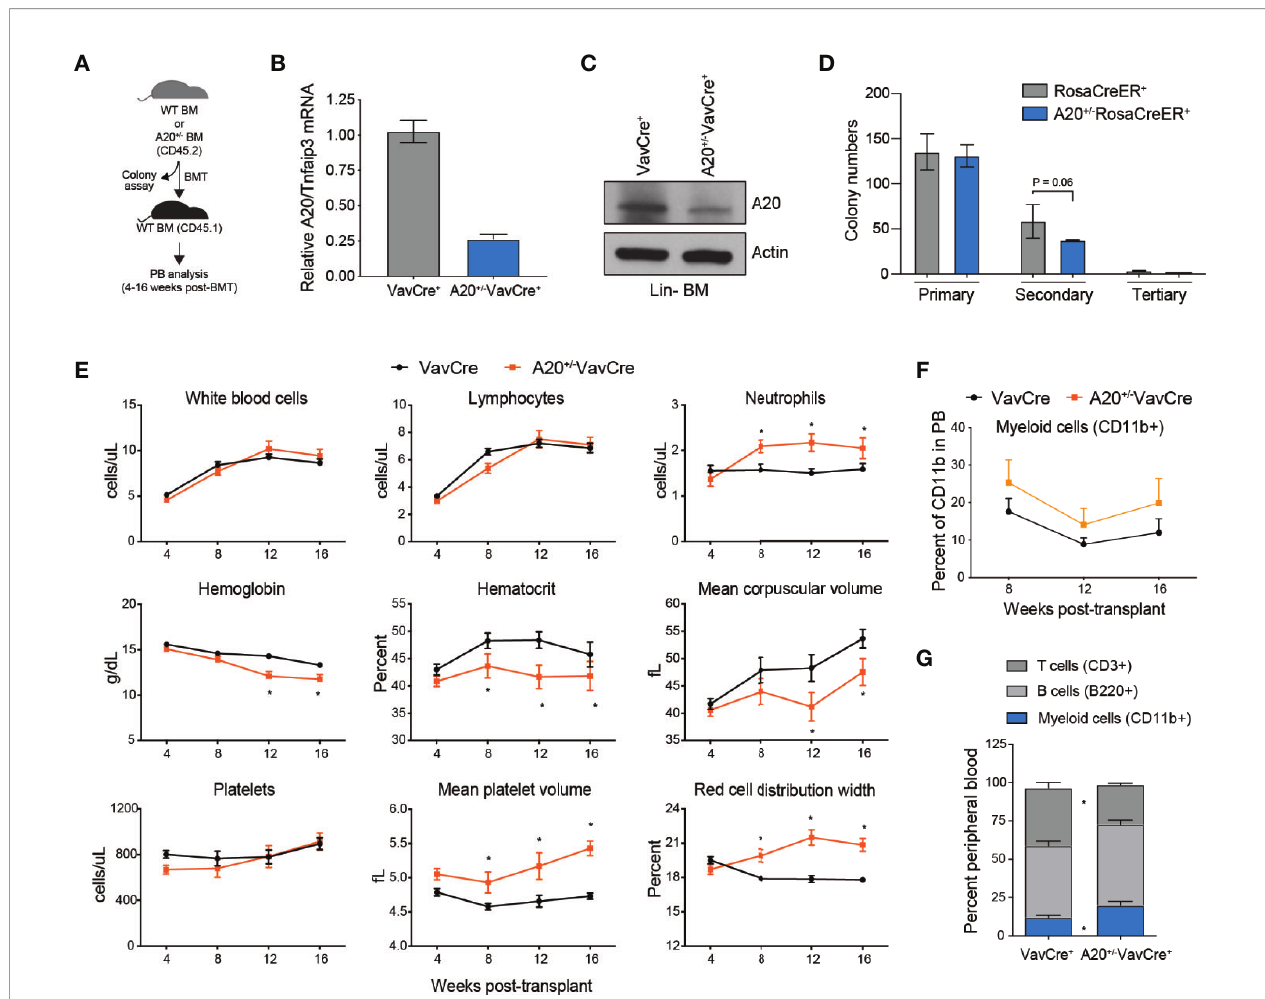
FIGURE 2 | Heterozygous deletion of A20 results in myeloid-biased hematopoiesis. (A) Outline of experiments utilizing WT (VavCre + or RosaCreER + ) and A20 +/- (A20 +/- VavCre + or A20 +/- RosaCreER + ) mice for colony progenitor function and PB analysis. (B) A20 mRNA expression by qRT-PCR in lineage negative BM (Lin- BM) cells from VavCre+ and A20+/-VavCre+ mice (n = 3 mice per group). (C) A20 protein expression by immunoblotting in Lin- BM cells from VavCre+ and A20+/-VavCre+ mice (pooled from two mice). ( D ) Colony formation in methylcellulose of BM LSK cells isolated from WT RosaCreER + and A20 +/- RosaCreER + mice (treated with tamoxifen). One-tailed T test from three mice per group. (E) Complete blood counts for WT (VavCre + ; n = 3) and heterozygous A20-de fi cient (A20 +/- VavCre + ; n = 6) mice at the indicated time points post BM transplantation. *P < 0.05. (F) Flow cytometric analysis of donor-derived (CD45.2 + ) myeloid cells (CD11b + ) in the PB from recipient mice reconstituted with BM from VavCre + (n = 7) or A20 -/- VavCre + BM cells (n = 7) (CD45.2 + ) at the indicated time points post- transplantation. (G) Flow cytometric analysis of donor-derived (CD45.2 + ) myeloid cells (CD11b + ) and lymphoid cells (CD3 + and B220 + ) in the PB from recipient mice reconstituted with BM from VavCre + or A20 -/- VavCre + BM cells (CD45.2 + ) at 16 weeks